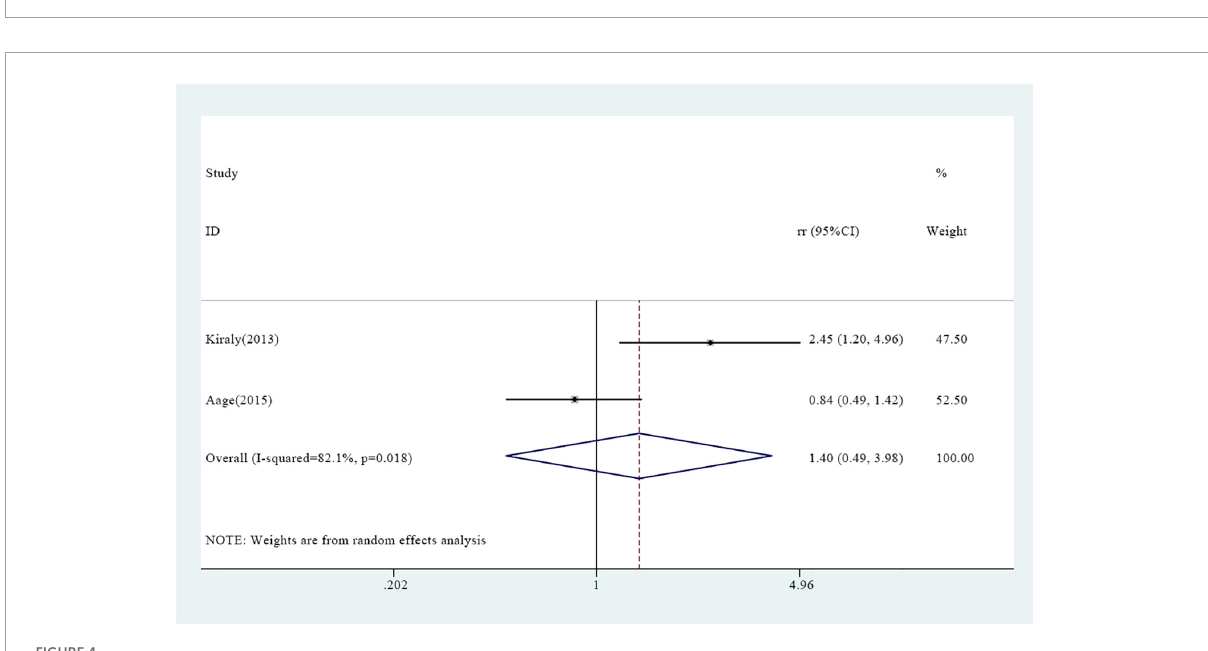
FIGURE4 Association between vitamin A supplementation and